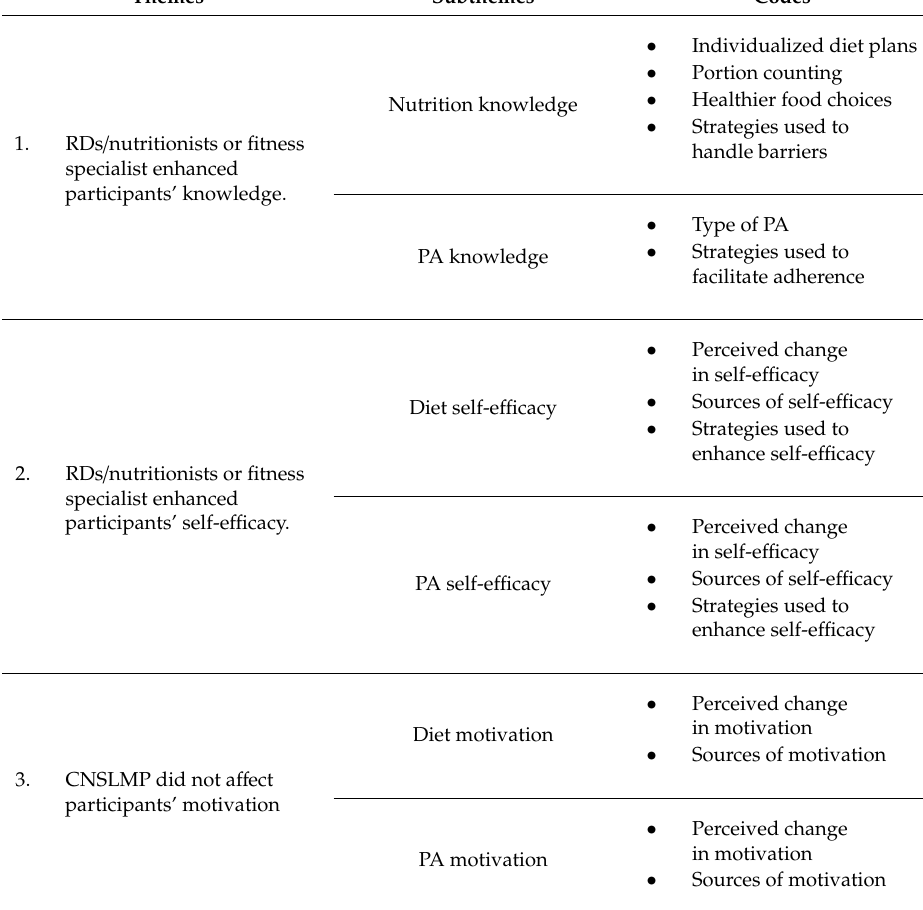
Table 6. Summary of the themes, subthemes and